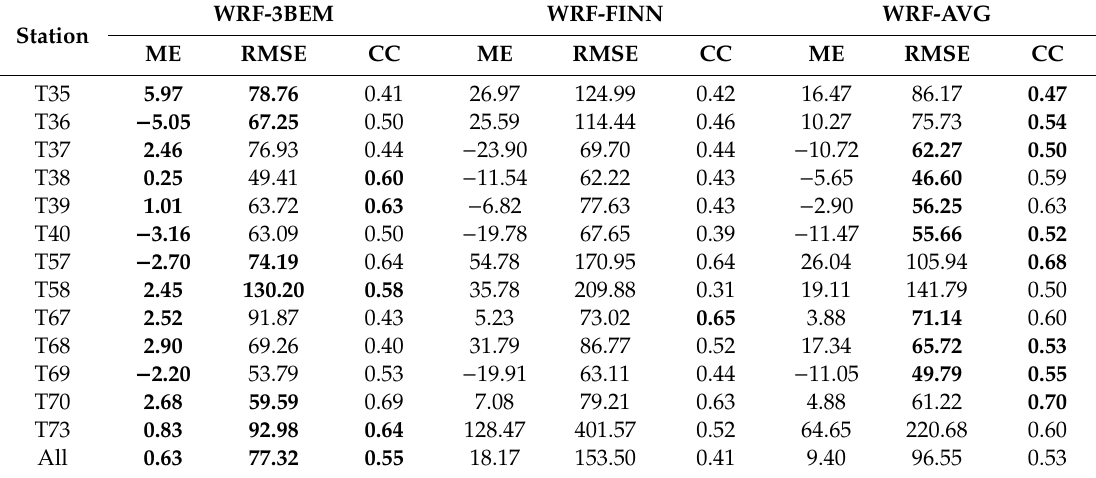
Table 4. MEs (E[simulations-measurements]), RMSEs, and CCs of simulations and measurements